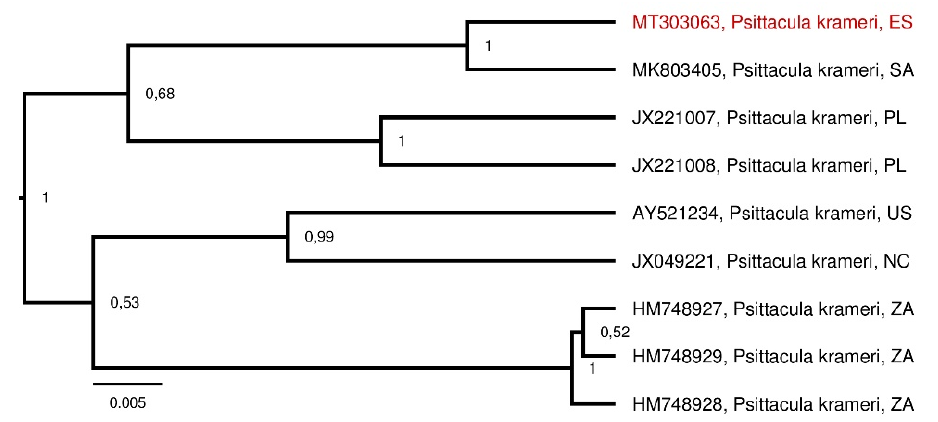
Figure 2. Maximum clade credibility tree inferred using partial nucleotide sequences of the BFDV rep gene isolated from rose-ringed parakeets ( Psittacula krameri ). Posterior probabilities are indicated for each node. All partial rep sequences are defined by GenBank accession number, species and country codes (ISO 3166-1 alpha-2). The novel circovirus genotype of Spain (ES) is highlighted. The partial BFDV sequences isolated from rose-ringed parakeets in Spain and Saudi Arabia differ in 9 (1.5%) nucleotides and 1 (0.5%) amino acid (Table 1). However, the pattern of nucleotide